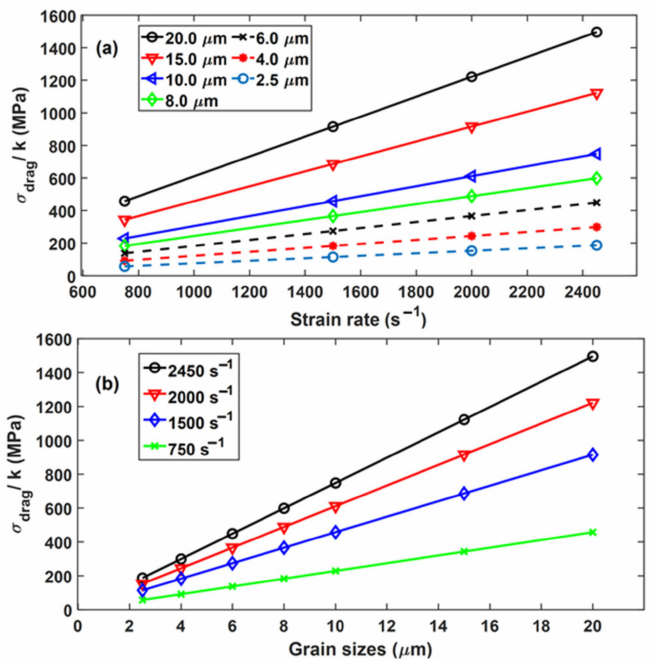
Figure 12. Viscous drag stress as a function of ( a ) strain rate for different grain sizes and ( b ) grain size at different strain rates.